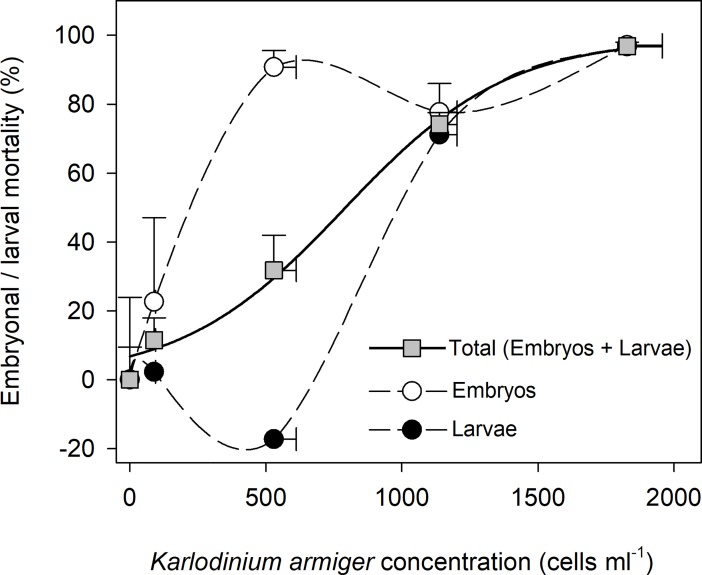
Mortality of Mytuilus edulis embryos and trochophore larvae after exposure to Karlodinium armiger at four different concentrations.Mortalities of embryos and trochophore larvae, separately and when pooled as a function of K. armiger cell concentrations. Data presented as mean values with SE bars.